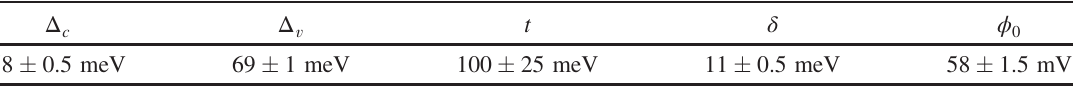
TABLE I. The measured conduction or valence band offset at the K points, the asymmetric interlayer coupling, the direct band-gap difference, and the polarization-induced interlayer potential in a 3 R -MoS 2 bilayer. Δ